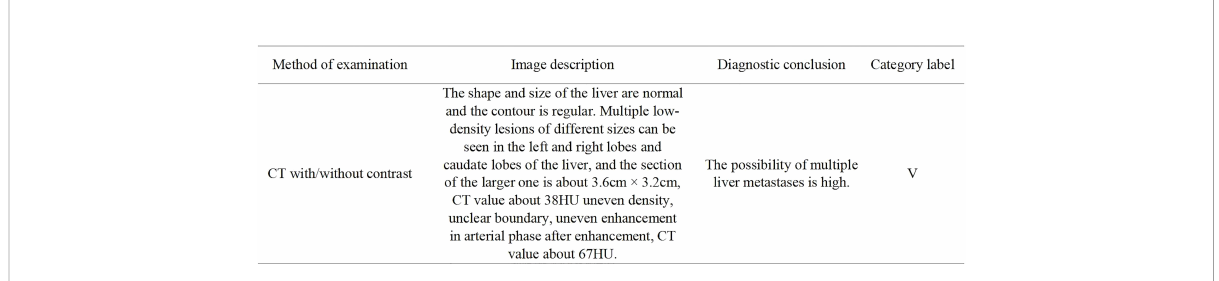
FIGURE 2 A representative original liver CT with/without contrast report and category label of patient with colorectal cancer. The report consists of an imaging description and diagnostic conclusion. For publication purposes, we provided English version of Chinese words from the imaging